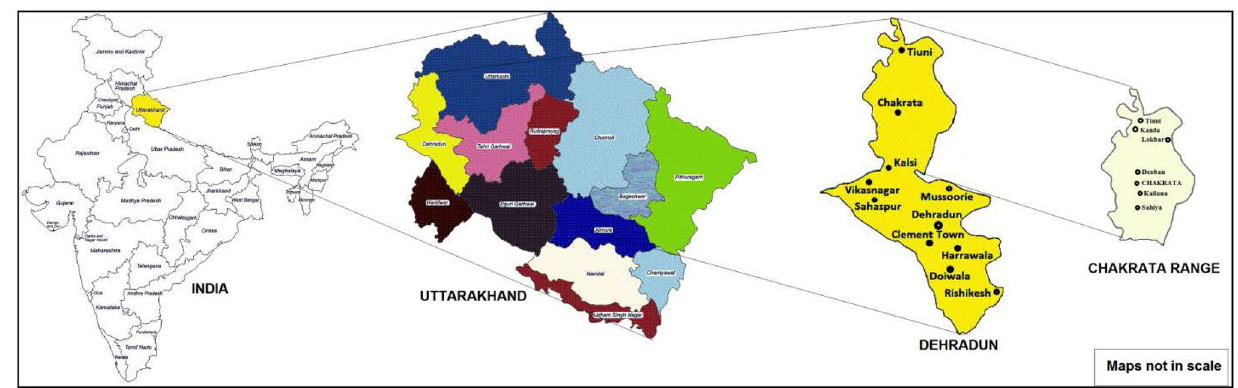
Fig. 1 Geographical location of Chakrata